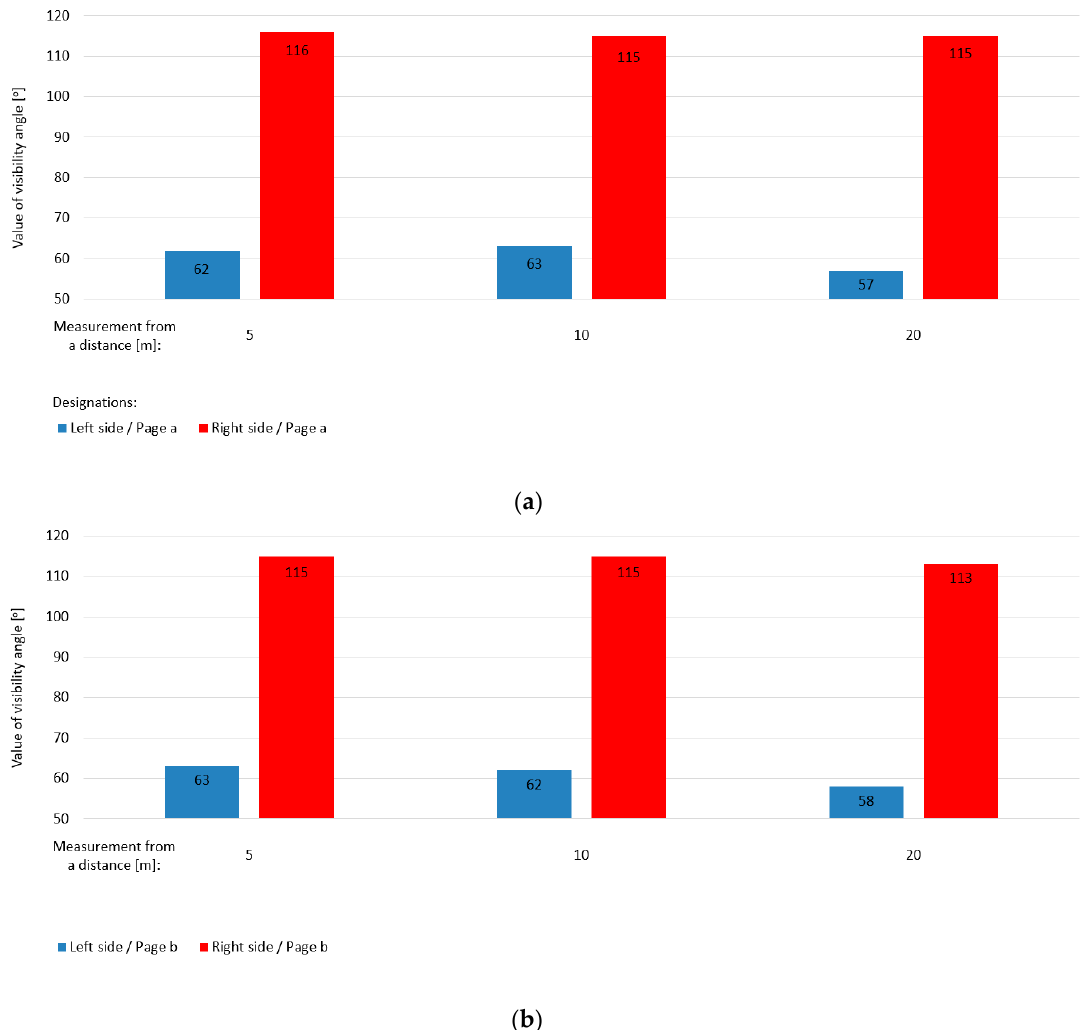
Figure 9. Values of the angles of visibility of the train front from the road for track no. 1: ( a ) left and right page “a”; ( b ) left and right page “b”.